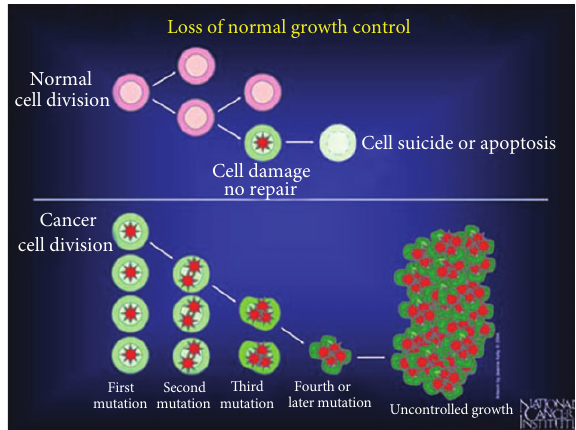
Figure 2: Mesenchymal stem cell with more lightly stained nucleus in bone marrow central to differentiating preosteoblastic stem cells above and below the stellate cell acquired during histomorphometry